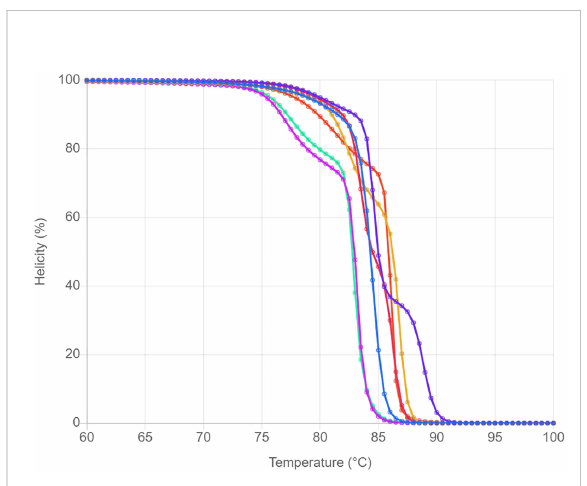
FIGURE 1 HRM pro fi les of seven jelly fi sh species analyzed with the uMELT Quartz. The curves showing in normalized melting